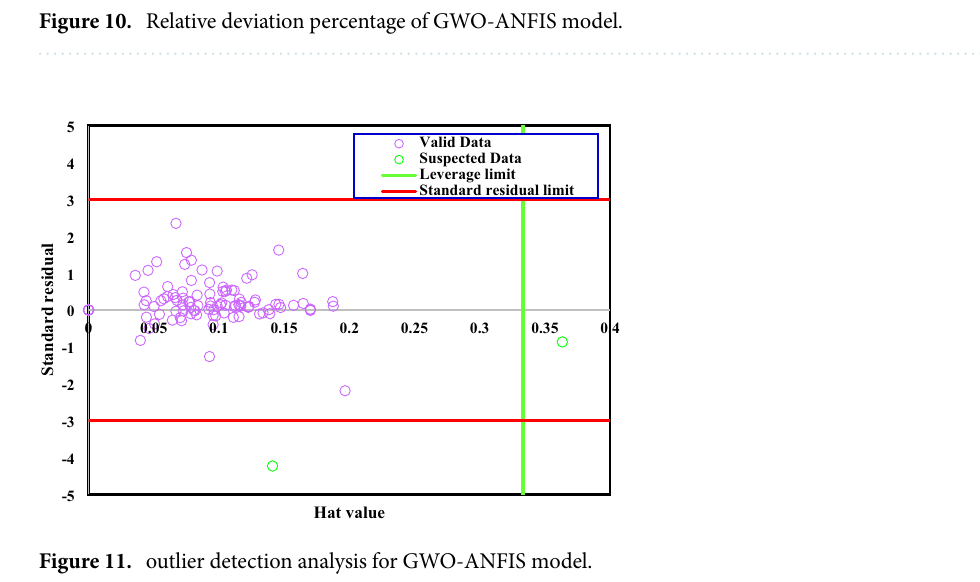
Figure 11. outlier detection analysis for GWO-ANFIS